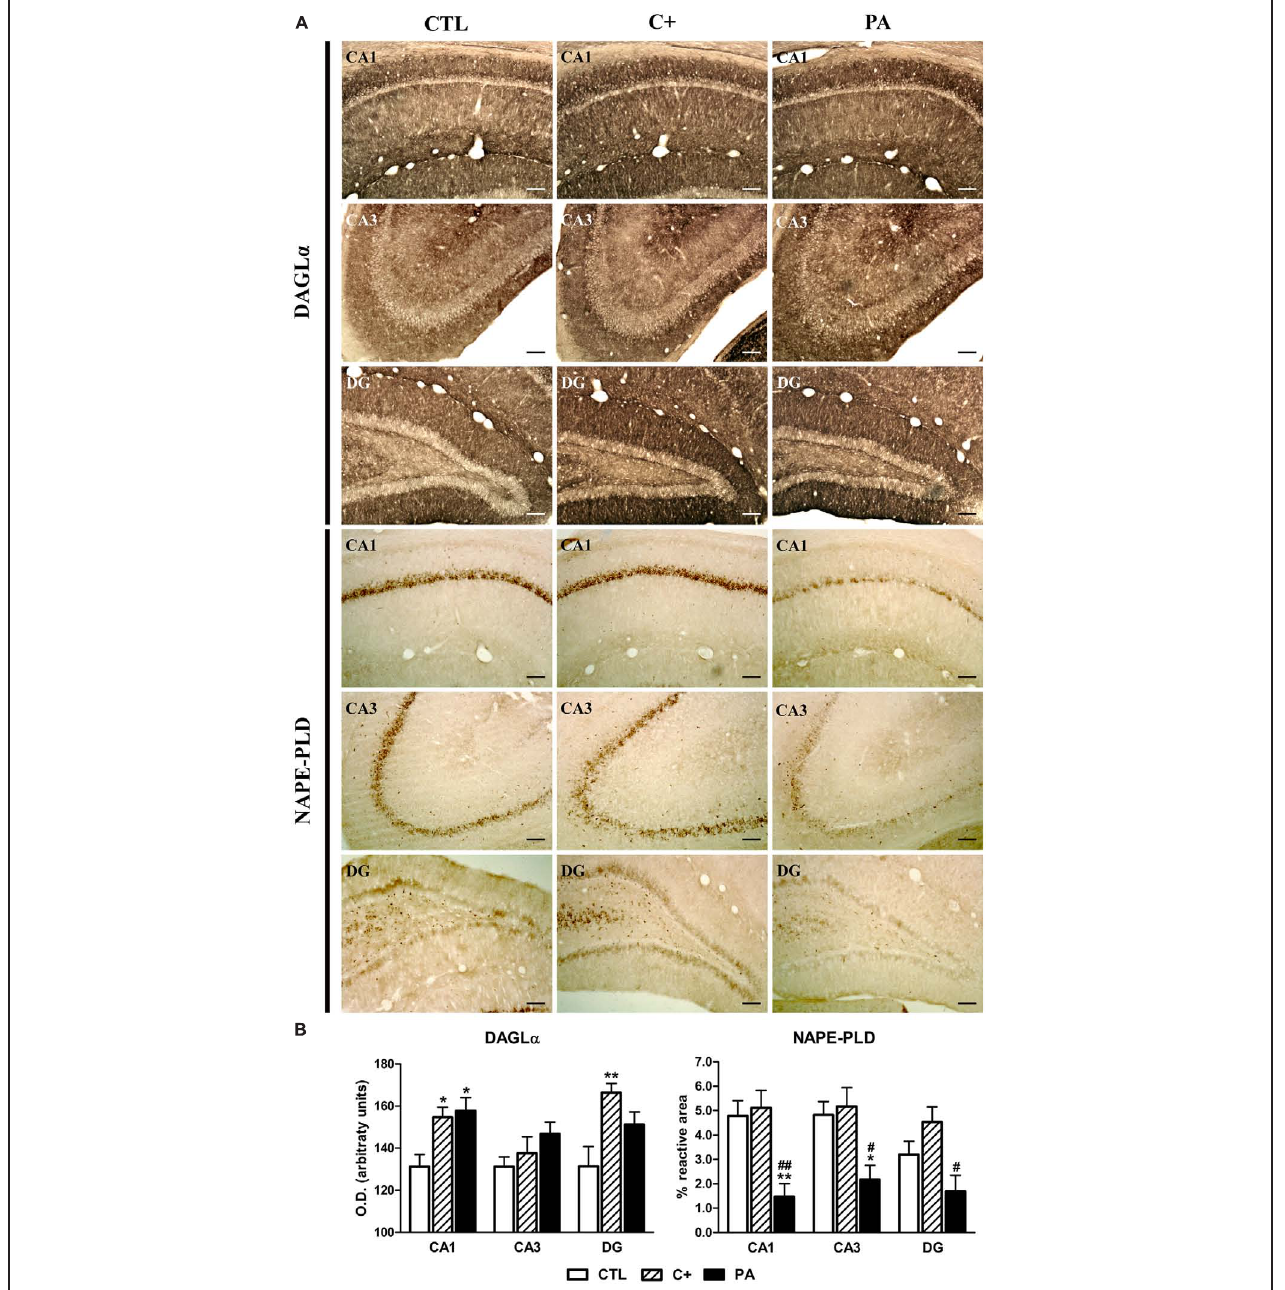
FIGURE 4 | Immunohistochemical expression of DAGL α and NAPE-PLD in dorsal hippocampus. (A) Photomicrographs showing DAGL α (upper panel) and NAPE-PLD (lower panel) immunostaining in CA1, CA3, and DG regions of the dorsal hippocampus in the different experimental groups. Scale bars = 17 μ m. (B) Immunostaining quantification of DAGL α (left panel) and NAPE-PLD (right panel) in CA1, CA3, and DG regions of the dorsal hippocampus in all groups. DAGL α immureactivity was measured by densitometry while NAPE-PLD positive immunostaining was quantified as the percentage of the stained area over the total area of the region of interest. Bars and error bars show the mean + SEM of 5–7 observations per animal of a total of six rats per group. ∗ p < 0.05 vs. CTL; ∗∗ p < 0.01 vs. CTL; # p < 0.05 vs. C + ; ## p < 0.01 vs. C + . CTL, control group; C + , cesarean section group; PA, perinatal asphyxia group; CA1, cornu ammonis 1; CA3, cornu ammonis 3; DG, dentate